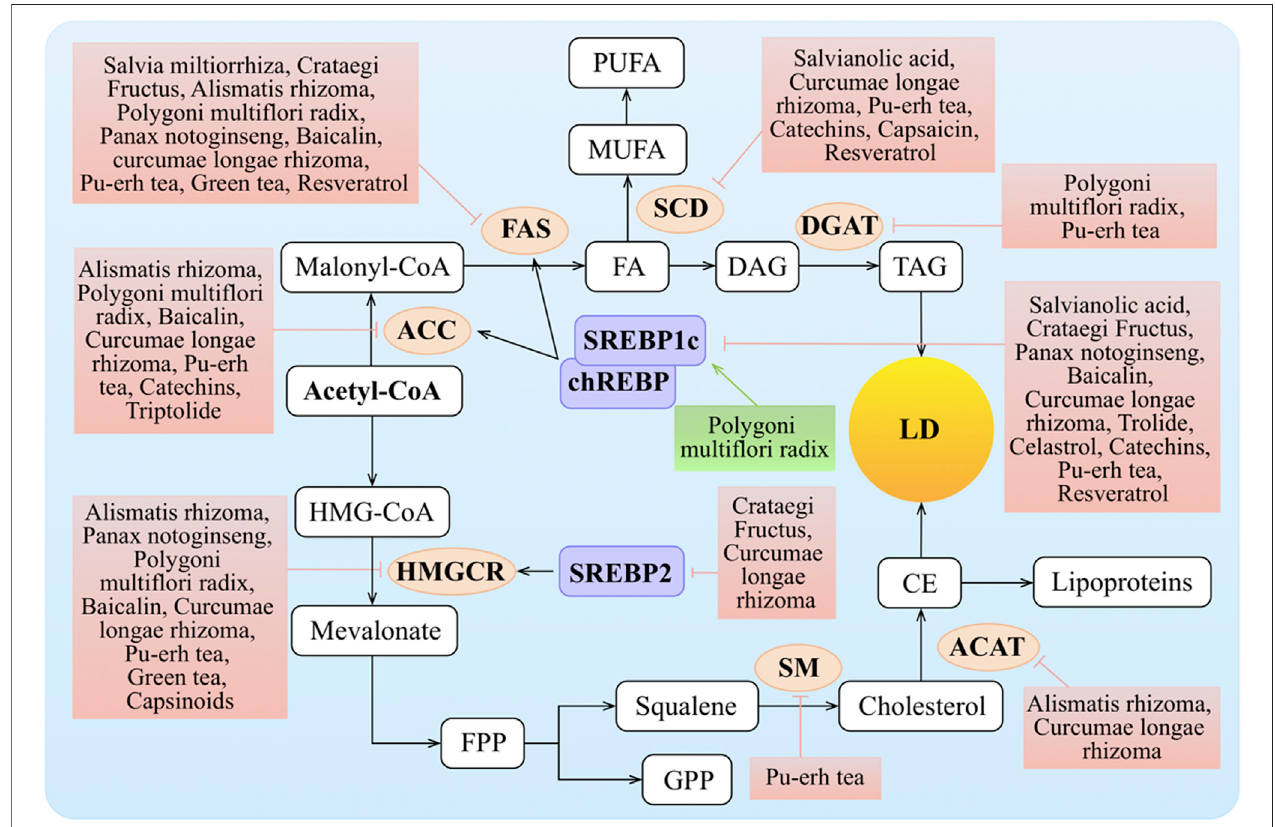
FIGURE 3 | Molecular mechanisms of TCMs in lipid synthesis. FA entering the hepatocyte is rapidly “ activated ” by acyl-CoA, and this is also termed the de novo lipogenesis (DNL) of FA. DNL is mainly regulated via the rate-limiting enzymes such as ACC and FAS, while the expression and activation of ACC and FAS are regulated by SREBP1c and chREBP. Transcription of the genes encoding SREBP1c and chREBP is stimulated by insulin via LXR and inhibited by FAs. The synthesis of MUFA regulates by SCD. FAs are typically esteri fi ed to TG and subsequently packaged into VLDL for export or stored as intracellular LDs. HMGCR and SM as the rate- limiting enzymes are key regulators of the synthesis process of cholesterol. Cholesterol can be converted to CE by ACAT for storage in LDs or for secretion as lipoproteins. Meanwhile, SREBP2 can increase the level of HMGCR. ↑ / ⊥ depicts the positive or negative effect of TCMs in the cellular process, respectively.